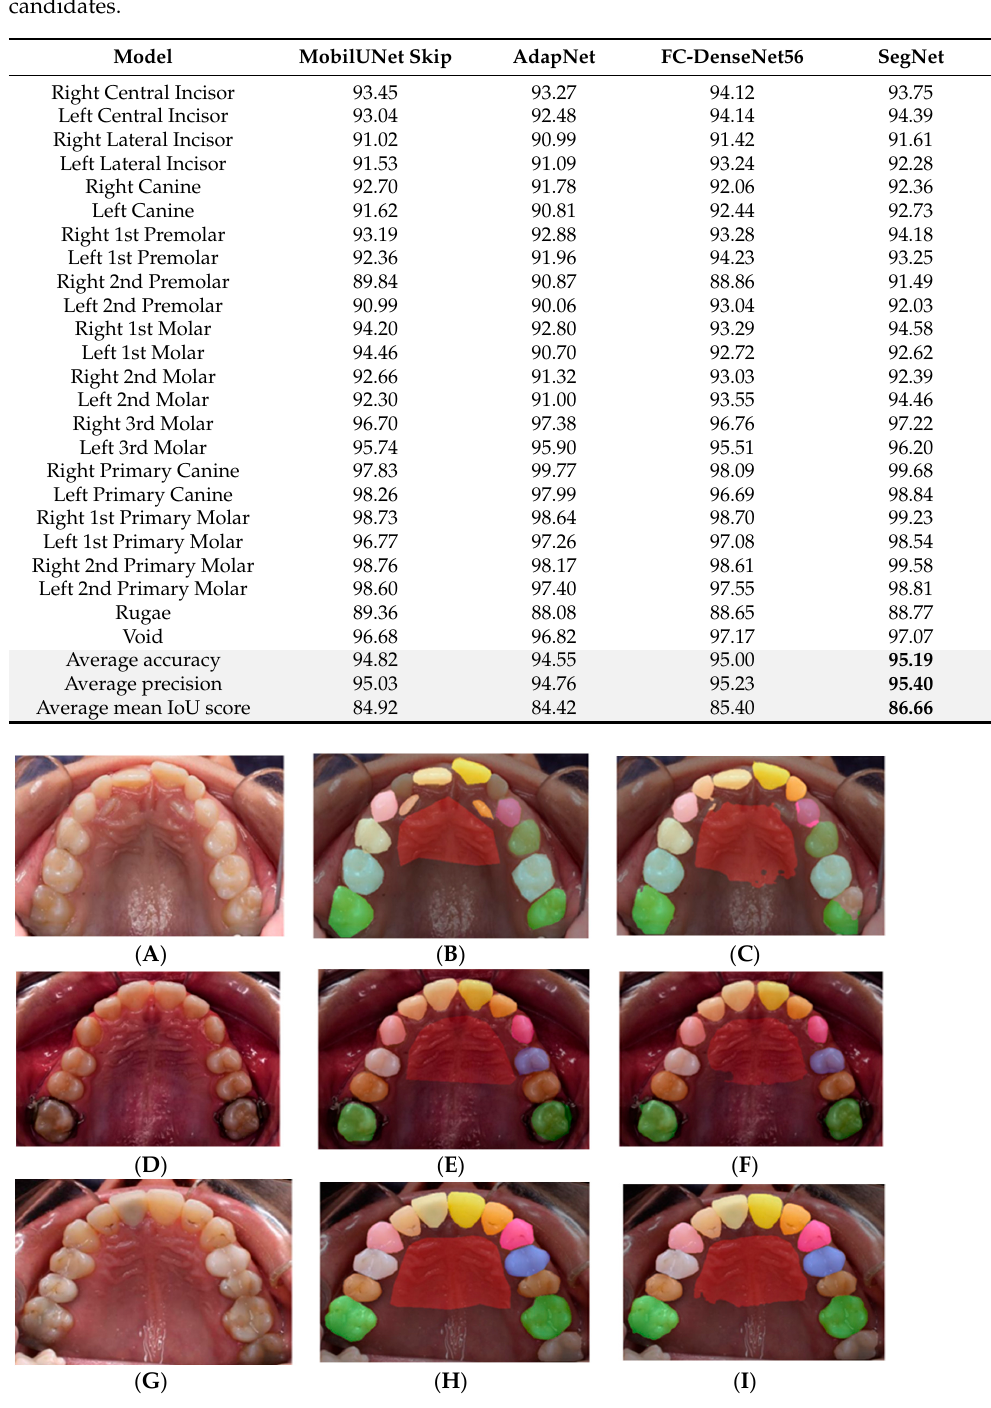
Figure 8. Individual Teeth Labeling results for SegNet including rotation dataset: original images ( A , D , G ); image labels ( B , E , H ); image predictions ( C , F , I ). In the first row ( A – C ) is the worst prediction is shown because the operator labeled the malaligned permanent lateral incisor, discarding the primary lateral ( B ), whereas the machine recognized the latter ( C ); in the second row ( D – F ) an average prediction is shown; the best result is shown in the third row ( G – I ). Table 4. Model architecture comparison on specific tooth labels with rotation for all architecture candidates.